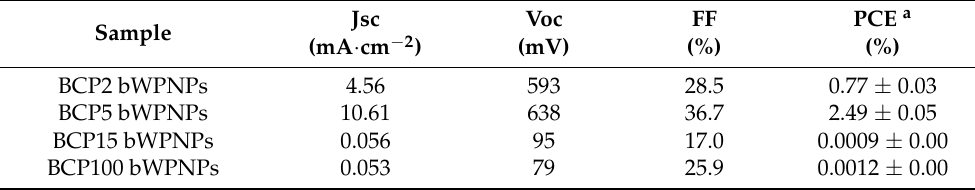
Figure 3. J − V curves of the devices based on BCP2 and BCP5 bWPNP dispersions ( left ) and on BCP15 and BCP100 bWPNP dispersions ( right ). Table 2. Figures of merit of the devices obtained with PCBM:BCP = 3:1 bWPNP active layers.